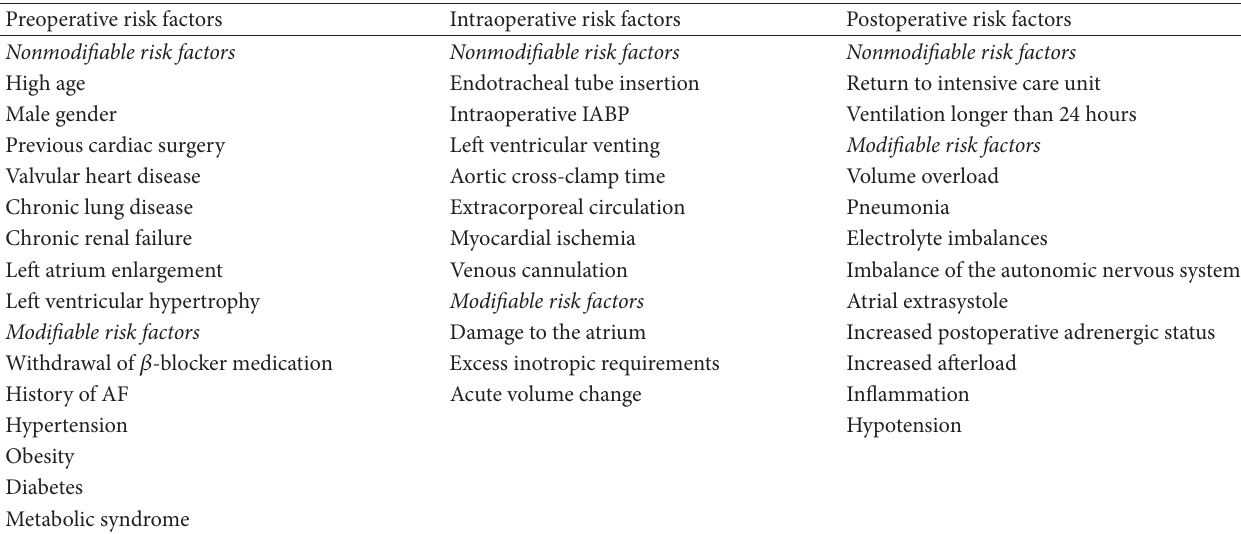
Table 1: Pre-, intra-, and postoperative (nonmodifiable and modifiable) clinical risk factors associated with